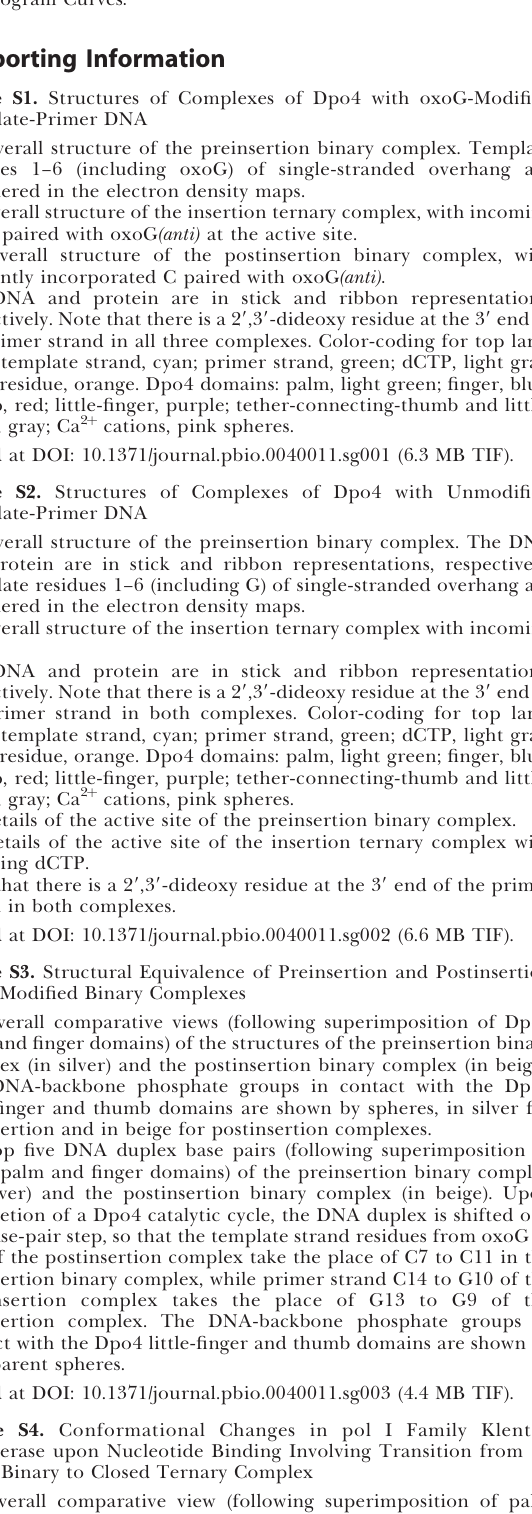
Figure S1. Structures of Complexes of Dpo4 with oxoG-Modified Template-Primer DNA